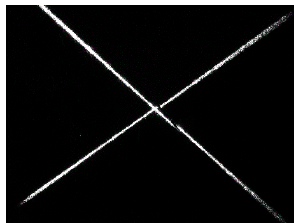
Figure 13. The original captured image of the cross line laser stripe.